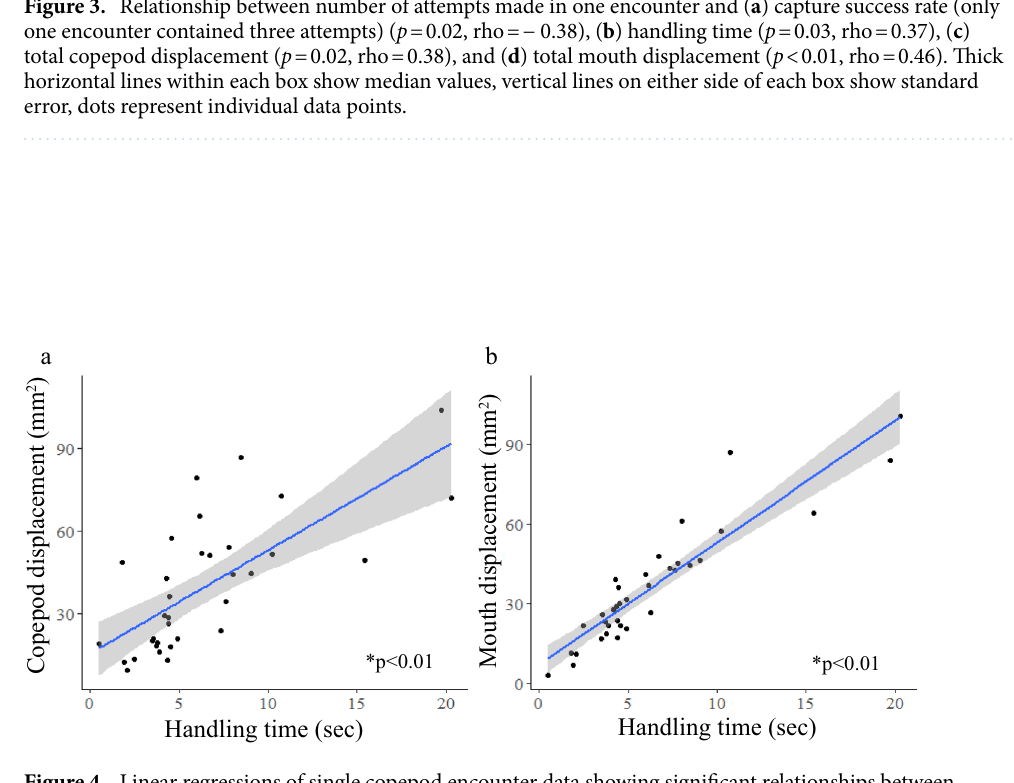
Figure 4. Linear regressions of single copepod encounter data showing significant relationships between handling time and ( a ) total copepod displacement ( p < 0.01, r 2 = 0.49) and ( b ) total mouth displacement ( p < 0.01, r 2 = 0.84). Statistical calculations were performed using log transformations, but data are shown with no transformations. Grey shaded region shows 95% confidence